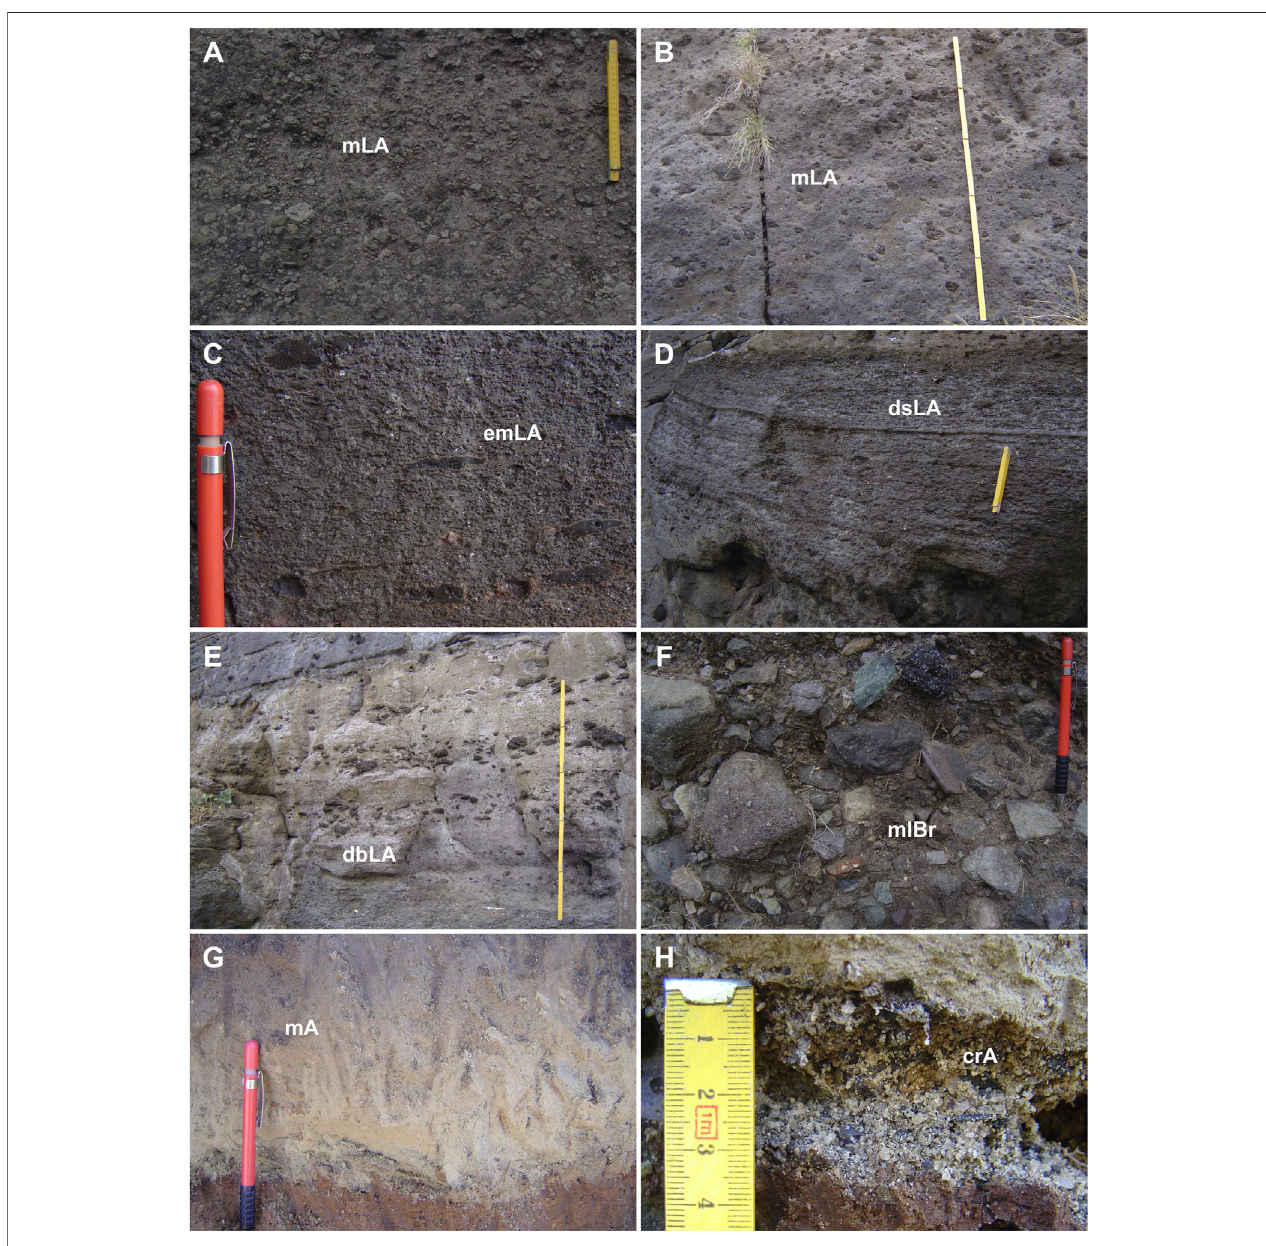
FIGURE 5 | Lithofacies of the LAI. (A) Massive lapilli-ash (mLA) from the Angra Ignimbrite (TERL63 in Figure 7 ; 20 cm scale). (B) Lithi fi ed massive lapilli-ash (mLA) fromtheLajesIgnimbrite(TERL2in Figure8 ;1 mscale). (C) Eutaxiticmassivelapilli-ash(emLA)fromtheLajesIgnimbrite(TERL61in Figure7 ;penforscale). (D) Diffuse- strati fi edlapilli-ash(dsLA)and (E) diffuse-beddedlapilli-ash(dbLA)fromtheLajesIgnimbrite(bothfromTERL59in Figure7 ;Dscaleis20 cm;Escaleis1 m); (F) Massive lithicbreccia(mlBr)fromtheLajesIgnimbrite(TERL39in Figure8 ;penforscale); (G) Massiveash(mA)fromtheLajesIgnimbrite(TERL20in Figure8 ;penforscale). (H) Crystal-rich ash (crA) from the Lajes Ignimbrite (TERL18 in Figure 8 ; scale in cm).